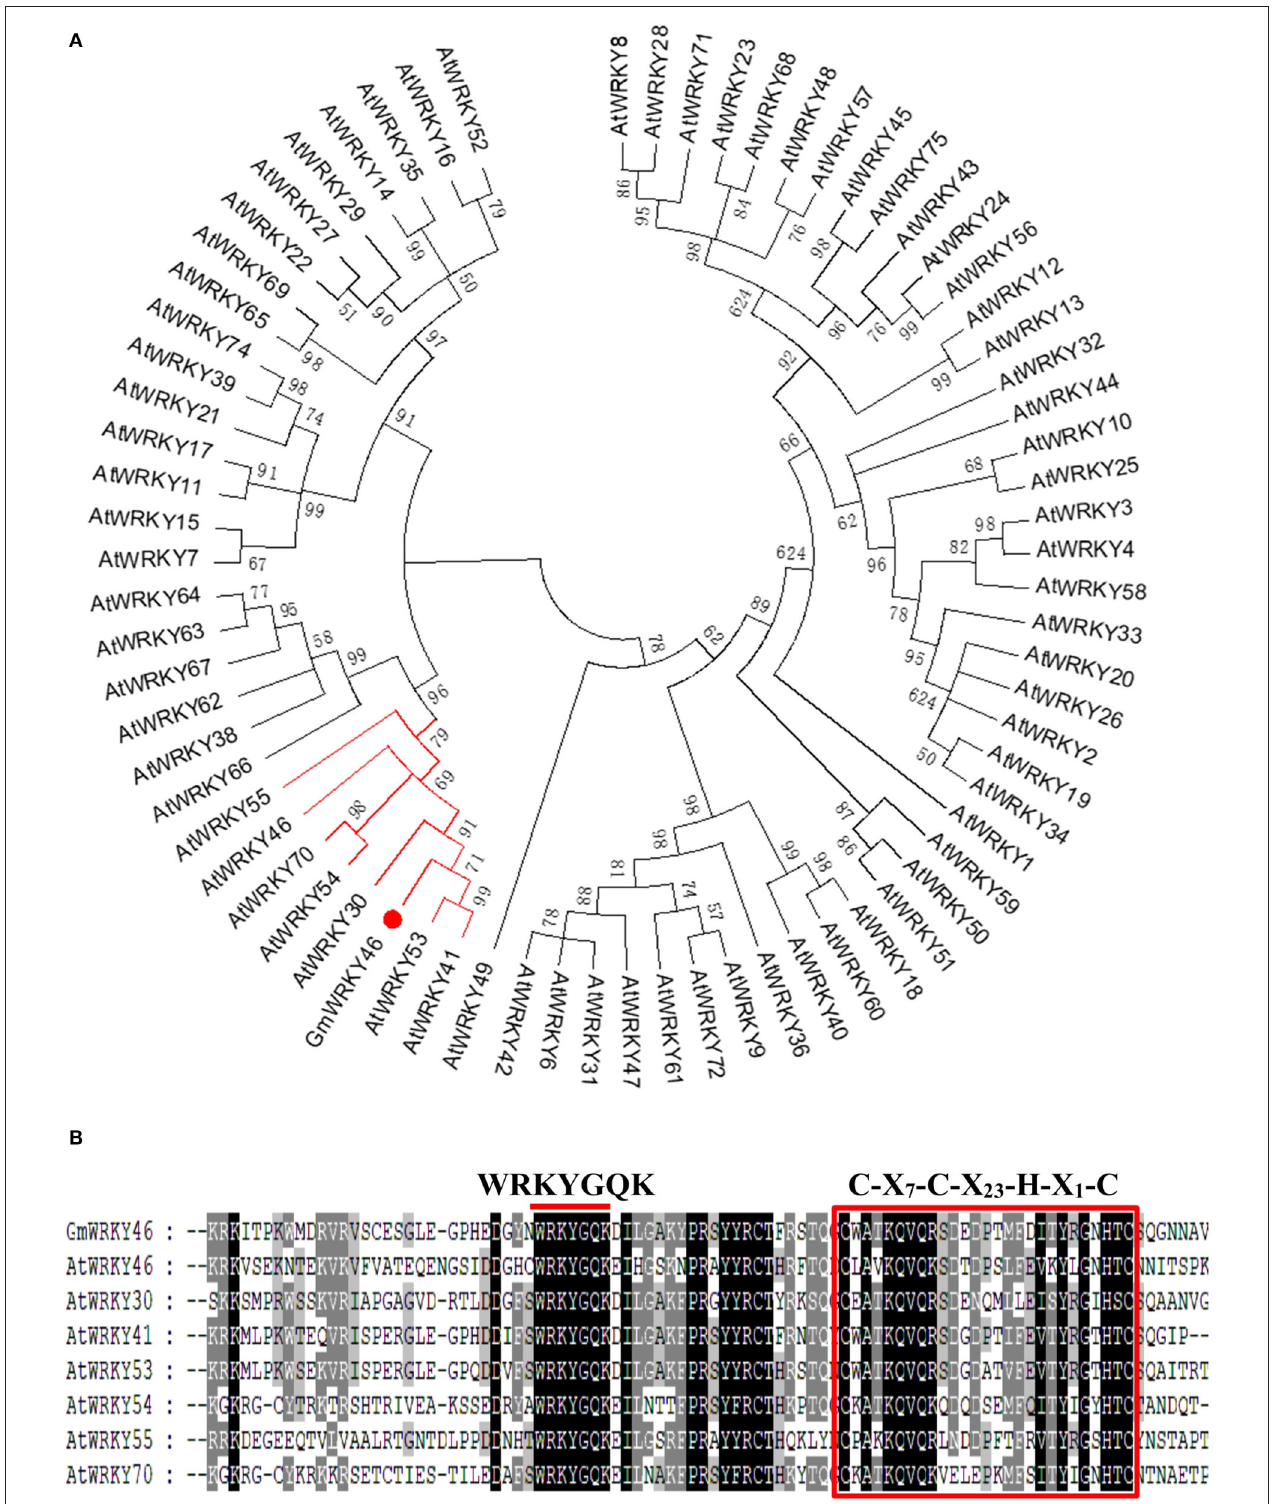
FIGURE 1 | Homology characterization and structure of GmWRKY46. (A) a phylogenetic comparison was made between the sequences of the GmWRKY46 protein and the Arabidopsis WRKY family proteins. The red line showed proteins with high homology to GmWRKY46. (B) Multi-sequence alignment between GmWRKY46 and its highly homologous Arabidopsis WRKY protein. The red bar above the sequences represented the highly conserved WRKYGQK domain. The red square represented the N-terminal C-X 7 -C-X 23 -H-X 1 -H zinc-finger structure.